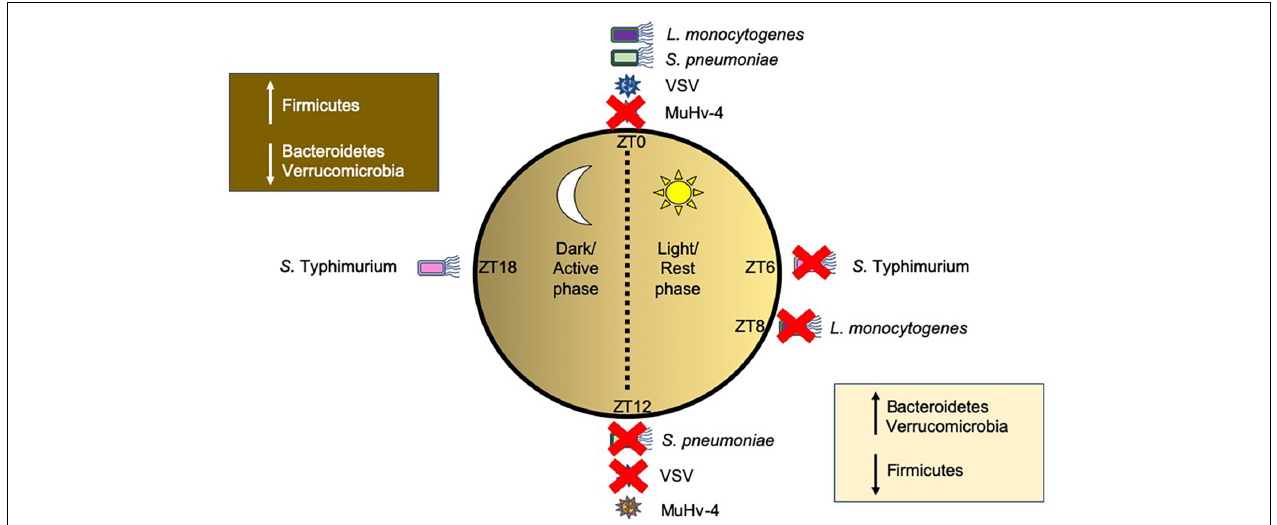
FIGURE 3 | Time-of-day-dependent changes in modulating host susceptibility to pathogens. Host circadian rhythms influence the promotion of bacterial and viral disease depending on the time-of-day that the host was infected. Pathogens are shown around a circle representing different times of day with ZT0 representing the start of the circadian cycle (Bmal1 induction) and rest/light phase and ZT6, ZT8, ZT12, and ZT18 representing 6, 8, 12, and 18 h past light onset, where at ZT12 the dark/active phase starts. Red crosses indicate a time-of-day the host immune response is better prepared to prevent infection, while pathogens without a red cross indicate a time that is better suited for the pathogens to cause disease. This figure was generated from published murine studies. Other pathogens, including human pathogens, are likely to follow similar patterns. Changes in commensal gut microbial species at different times-of-day are also shown in boxes. Abbreviations: ZT, Zeitgeber, S. pneumoniae ( Streptococcus pneumoniae ), S. Typhimurium (Salmonella Typhimurium), L. monocytogenes ( Listeria monocytogenes ); VSV, Vesicular stomatitis virus; Mu-HV-4, Murid herpesvirus